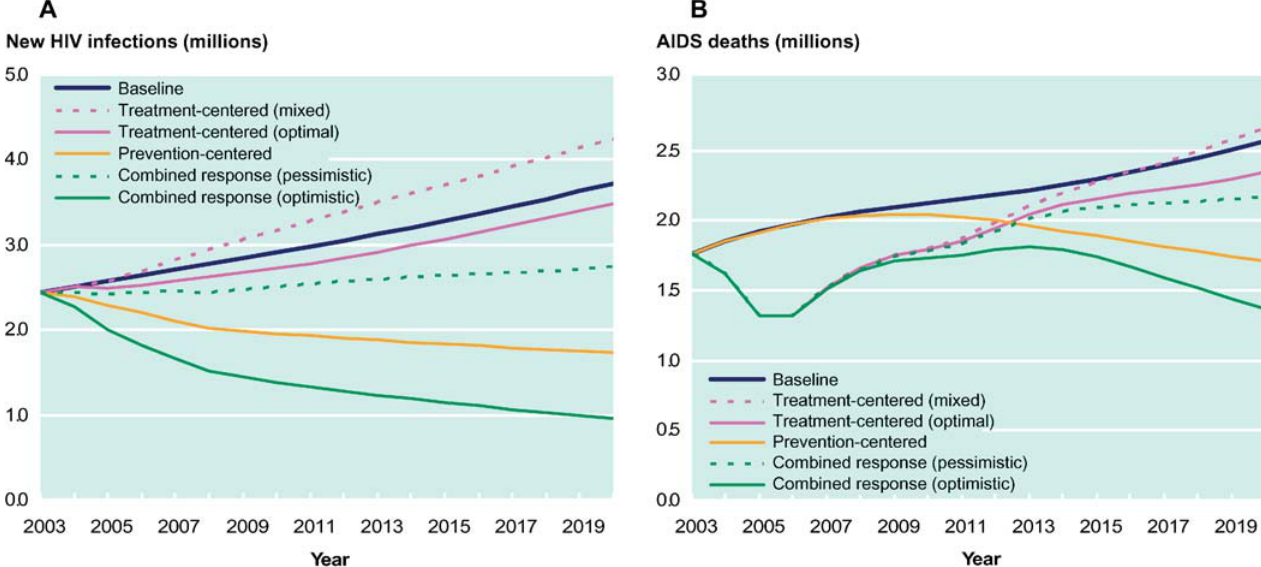
Figure 1. HIV Incidence and AIDS Mortality among Adults in Sub-Saharan Africa, 2003–2020, under Different Intervention Scenarios (A) HIV incidence. (B) AIDS mortality. DOI: